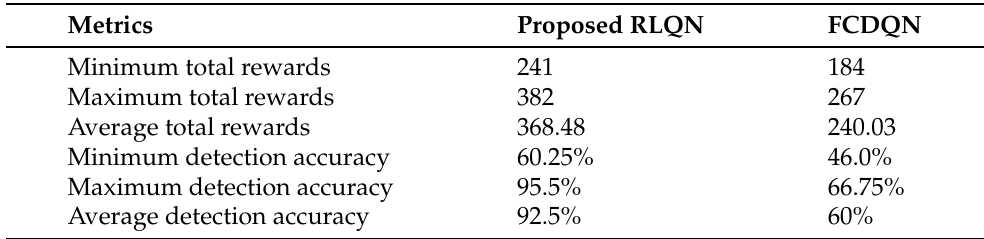
Table 3. Summary comparison of the experimental results between the proposed RLQN and FCDQN within 400